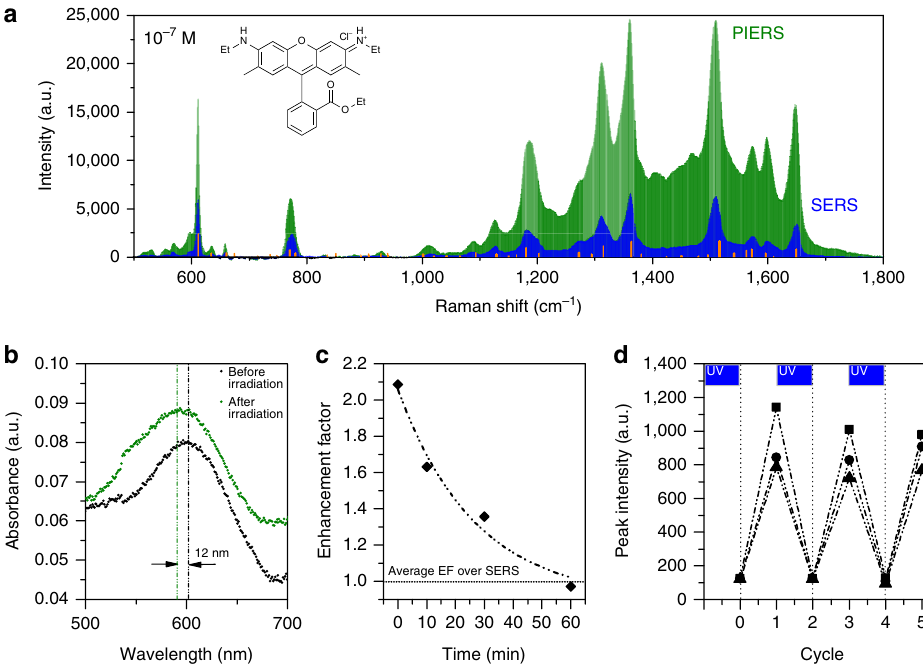
Figure 3 | PIERS spectra and examining the PIERS mechanism. ( a ) PIERS (green) and SERS (blue) spectra of Rhodamine 6G (10 (cid:2) 7 M), with Raman modes of the solid shown by the orange lines. All spectra collected under identical collection conditions. ( b ) Absorption spectra of a thin film showing LSPR shifts for AuNPs on TiO 2 (R) after irradiation with 254nm light (3h). Note that the AuNP pre-irradiation LSPR is red-shifted from its solution value, due to the high-refractive index of the TiO 2 surface compared with water. Dashed lines indicate peak position ( c ) Average of total spectral enhancement (EF) of PIERS over SERS for dinitrotoluene (10 (cid:2) 9 M) over time (full spectra in Supplementary Fig. 3). Horizontal line indicates the normal SERS intensity. ( d ) Demonstrating the recyclability of the substrate on irradiation to clean and re-charge for measuring DNT (10 –9 M) at three wavelengths, 1,315cm (cid:2) 1 (squares), 1,367cm (cid:2) 1 (circles) and 1,385cm (cid:2) 1 (triangles) (full spectra in Supplementary Fig. 4). Sample irradiation cycles with 254nm light are marked with blue boxes, then spectra are taken before (on the vertical lines) and after adding DNT, before